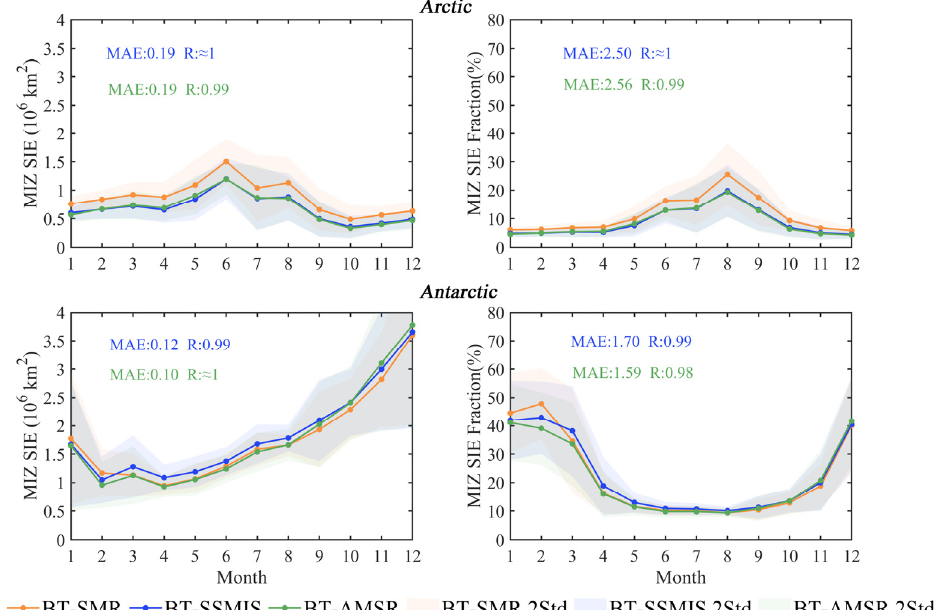
Figure 17. Monthly MIZ SIE and MIZ SIE fraction during 2019–2021. Additionally, the differences in MIZ SIE and MIZ SIE fraction between the BT-SMR and BT-SSMIS (blue number) and between the BT-SMR and BT-AMSR2 (green number) are shown. The shading presents the 2 STDs from the monthly MIZ SIE and MIZ SIE fraction.